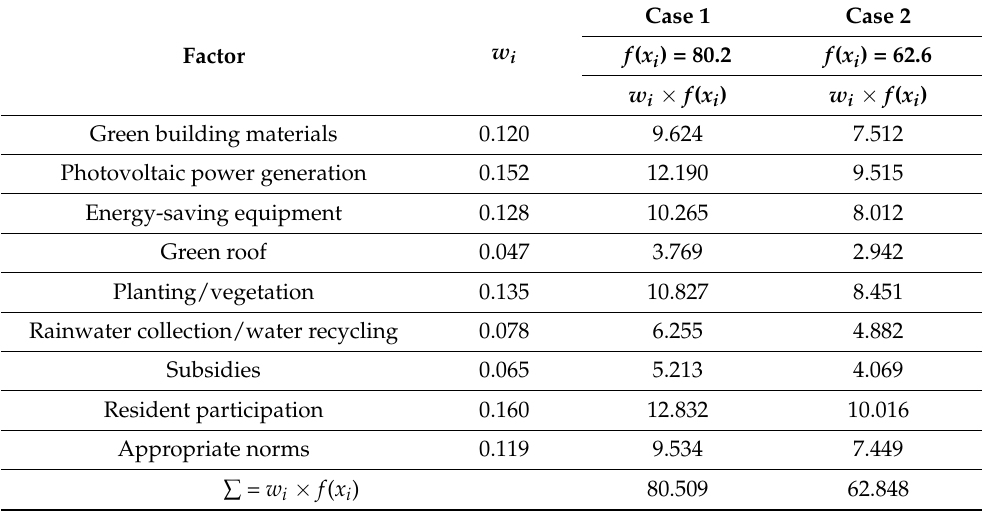
Table 11. Output values of each factor of the residential houses (cases 1 and 2) from the DA-Fuzzy model.